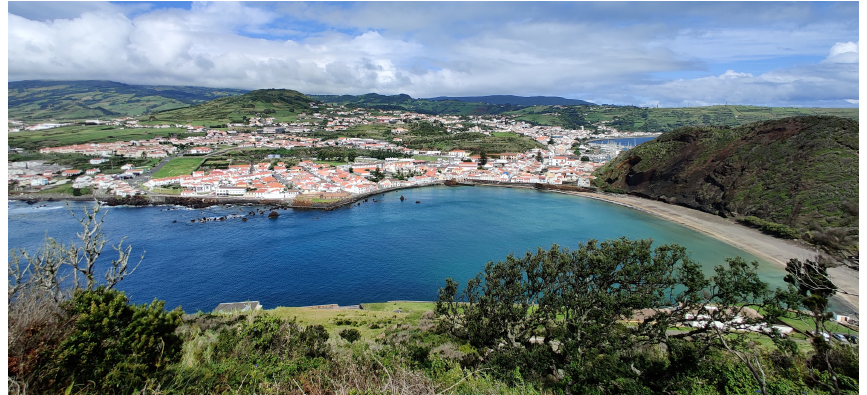
Figure 1. Porto Pim Bay Faial Island